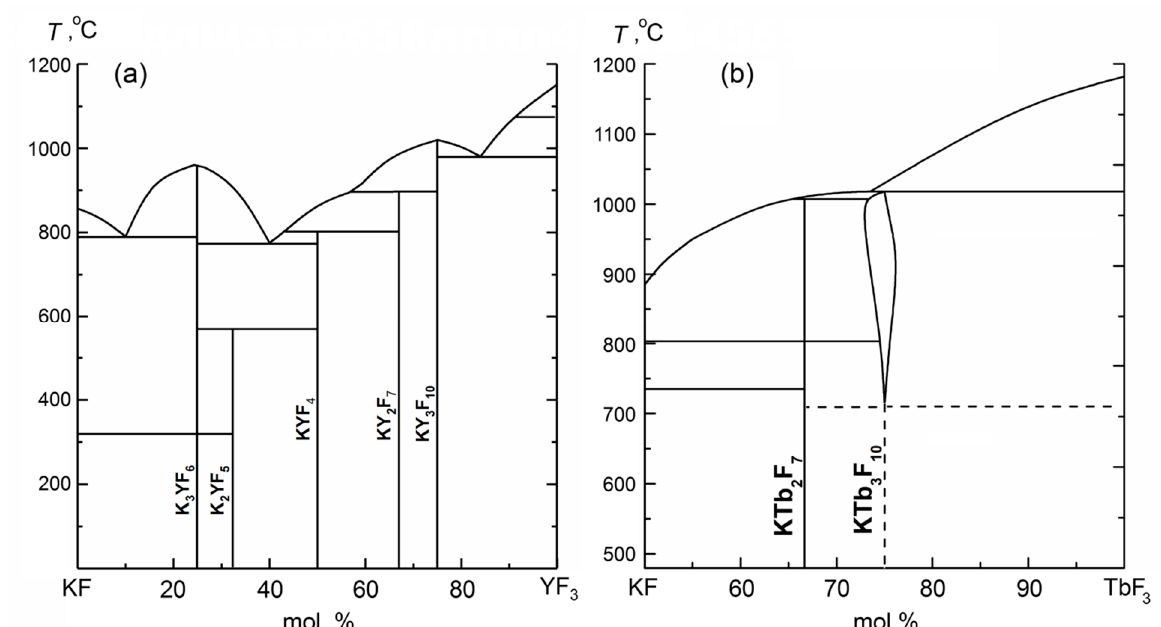
Figure 2. Phase diagrams of KF–YF 3 [29] ( a ) and KF–TbF 3 [25] ( b ) systems.